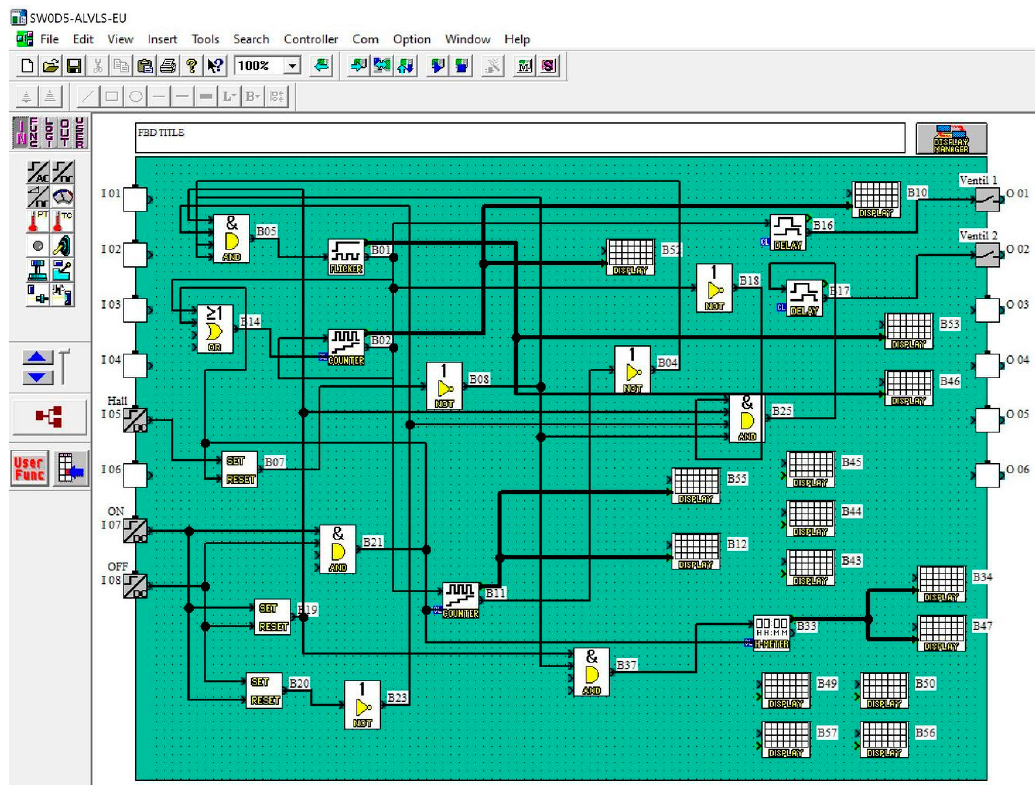
Figure 10. PLC program for cyclic control of a pneumatic cylinder.